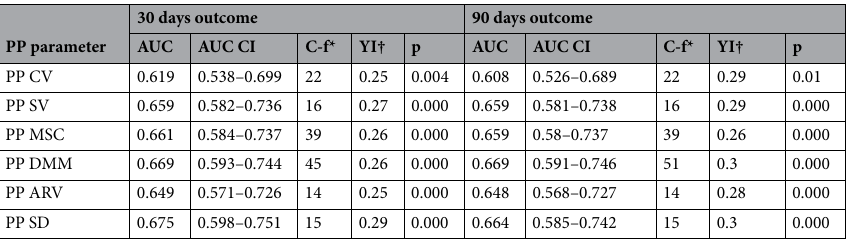
Table 4. The results of the ROC curve analysis determining predictive power of PPV indicators of unfavorable outcome at 30- and 90-days period after stroke onset. *C-f = Cut-off point. † YI = Youden’s Index. ARV: average real variability; AUC: area under the curve; CI: confidence interval; CV: coefficient of variation; DMM: difference maximum-minimum; MSC: maximal successive change; PP: pulse pressure; PPV: pulse pressure variability; SD: standard deviation; SV: successive variation.